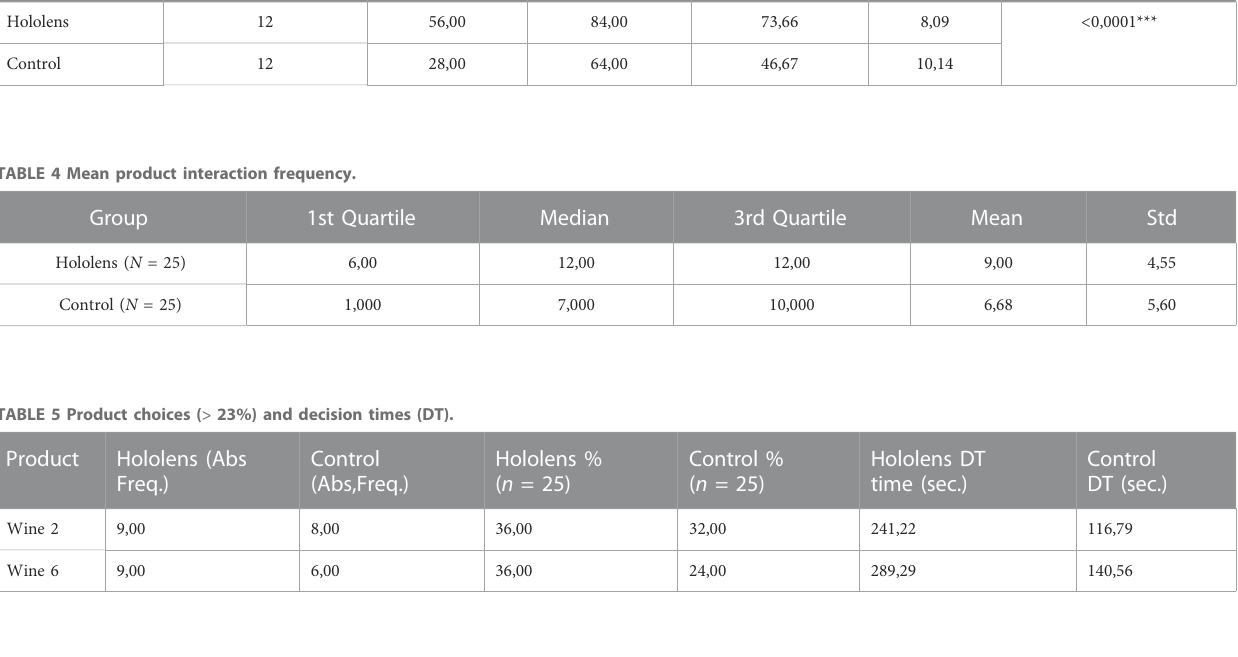
TABLE 3 Between-group differences in mean interaction frequency (%) with products. Group